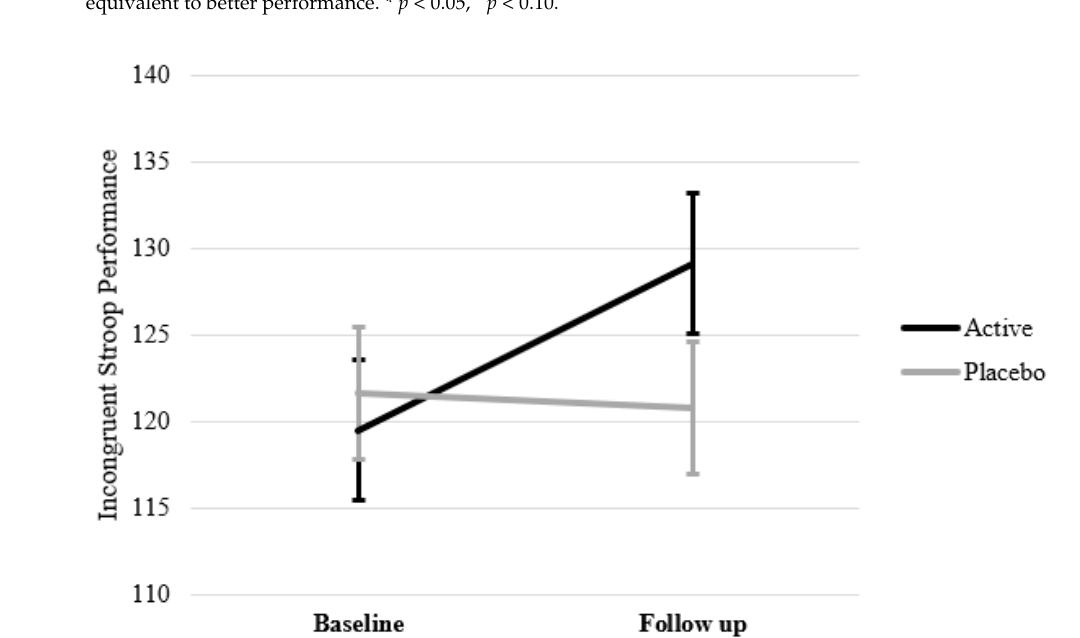
Figure 3. Incongruent Stroop Performance (Attention) in individuals with an ‘optimal’ diet at baseline and follow up (12 weeks) after adjusting for age, gender, education, BMI, BDI-II and brachial blood pressure.